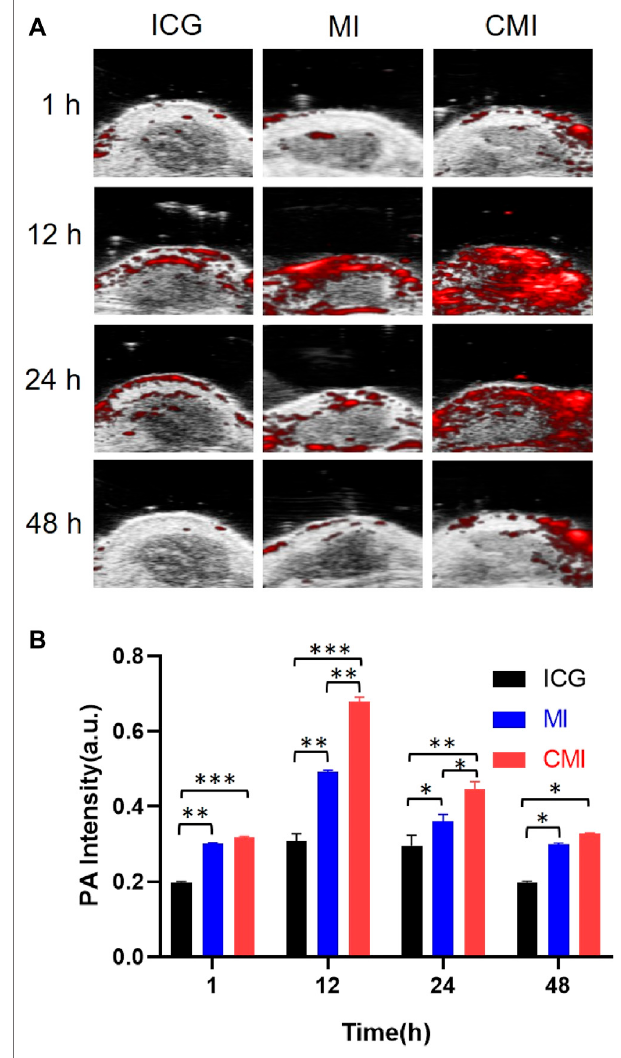
FIGURE6| In vivo PAimaging ofHelatumor – bearing nude mice. (A) PA images of the tumor region. (B) Fluorescent signal measurement of the tumor region.Thetumorswerecutinhalf,followedbytreatmentwithICG,MI,orCMI (containing an ICG dose of 10 mg/kg) injected into the Hela tumor- bearing nude mice through the tail vein (n (cid:2) 3/group). At 1, 12, 24, and 48 h after injection, the fl uorescent signals were measured by using the Step and Shoot mode with 100 angles and 15 pulses per angle in the V evo LAZR-X multimode imaging system. The results were processed by V evo LAB 3.2.0 software (* < 0.05; ** < 0.01; *** <